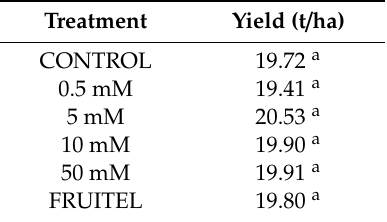
Table 1. Yield of Vitis vinifera L. cv Alicante Bouschet vines of non-treated (CONTROL) plants, HB weekly-treated plants at di ff erent concentrations (0.5, 5, 10, 50 mM) and plants treated with the ripening inducer FRUITEL. An ANOVA test was performed. The letter “a” indicates that no statistically significant di ff erences were